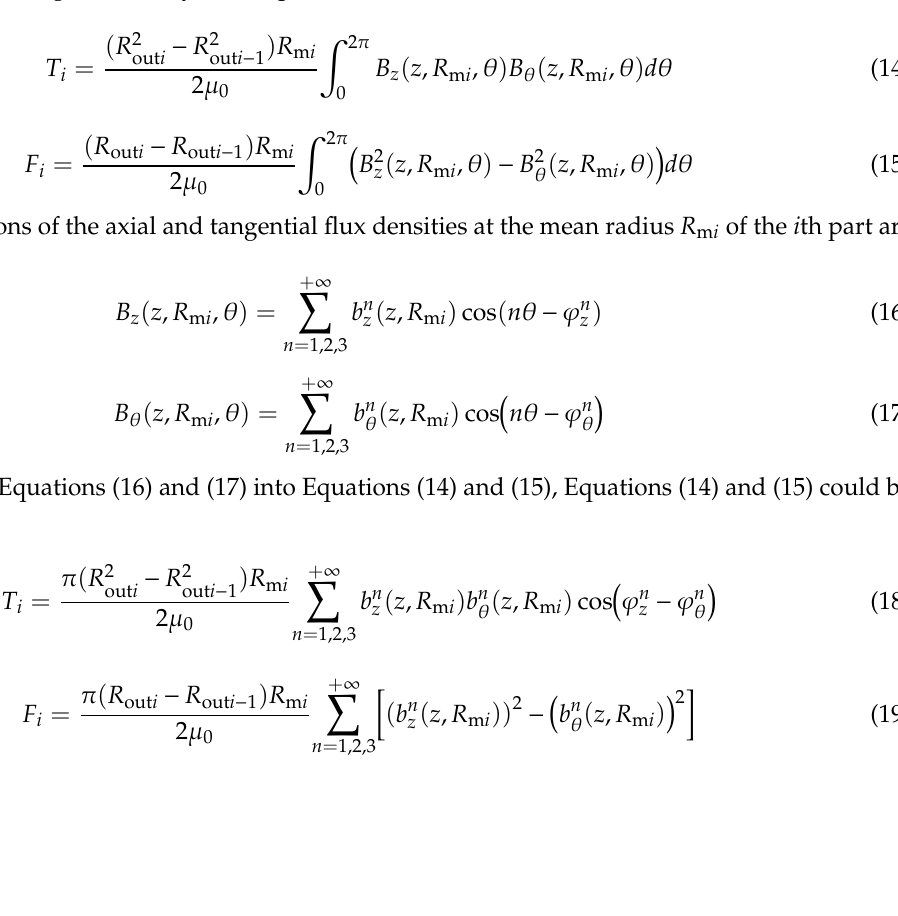
Figure 3. Air-gap separation diagram.